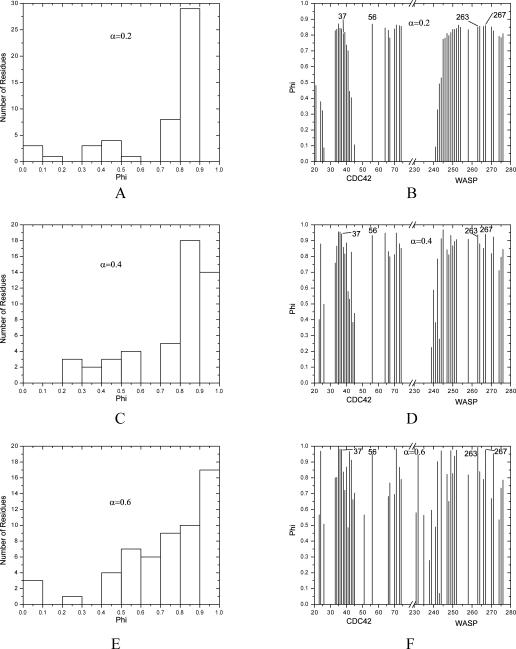
Distribution of Phi Values and Phi Values versus Protein-Primary Sequence for Different α